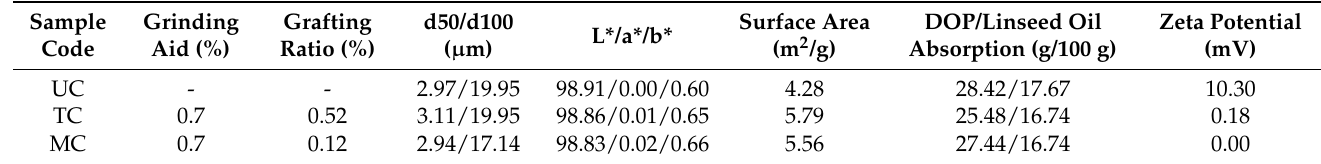
Table 1. Properties of CaCO 3 powders used in this